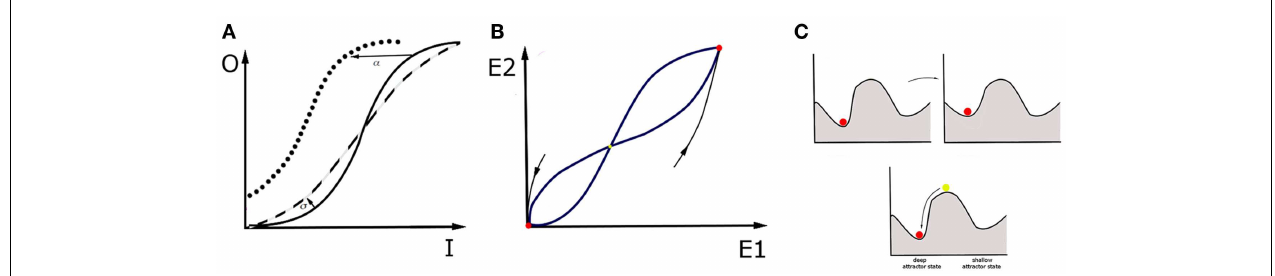
FIGURE 2 |Wilson–Cowan model and a “ball” metaphor .The activity of a single brain area within the network is a consequence of the synaptic inputs from other areas, the modulatory tone generated by diffuse projections, and the recurrent connectivity within the brain area itself.The activity reflects a specific balance between excitation and inhibition within the area. For simplicity, we describe the activity by one variable, E , for which the following = − E + f ( α E + β I + γ M ) .The first term on the right tells equation holds: τ dE dt us that in the absence of any drive (provided by the second term), the activity decays to zero with time scale τ .The second term incorporates the contribution of recurrent connectivity via E itself, input from other areas, represented by I , and the level of neuromodulation, represented by M . Each of these contributions are weighted by factors: α , β , and γ respectively.When the second term is positive, it increases the level of activity.The function f is a response function that translates the sum of activities into a driving term, . In this form, A is the maximum and is typically sigmoidal (106): f ( x ) = Ax 2 x 2 + σ 2 that f can reach for large x values, and σ is the value for which f is equal to half its maximum value. In addition, it also specifies how steeply f increases with x , a quantity that is also referred to as the gain factor. Note that this expression only holds for positive x values, f is zero when x is negative.This model has a range of parameters, which is important because each of them can be linked to specific physiological processes and changes in circuit structure. For instance, an increased β represents a stronger synaptic projection, whereas an increased α represents stronger recurrent synapses. An increased M reflects the effect of neuromodulators that increase the level of depolarization in the cells, and hence the baseline firing rate; γ reflects the sensitivity to neuromodulators of cells and circuits.The value of σ can be interpreted as a change in gain. (A) In a given region, the sigmoidal input-output (I-O) relationship has three regimes. For small input y << σ , it increases rapidly. For large inputs, y >> σ , it saturates. For values in between, it connects these regimes linearly. If the σ value, and thus excitability of the region, grows (dashed line), the I-O function is steeper than in the control case (solid line). If the region gets stronger recurrent connectivity, input from other regions or neuromodulation, so that the α , β , γ values grow respectively, I-O function shifts to the left (dotted line). (B) In an example of two interconnected regions, E 1 and E 2 , this dynamical system has three fixed points that are candidates for attractor states. In this example, two of them are stable (red). For a given attractor, setting activities E 1 , E 2 to arbitrary initial values within the basin of attraction will make the system move on toward this attractor.The third fixed point is unstable (yellow), which means that every small perturbation from this state makes the system